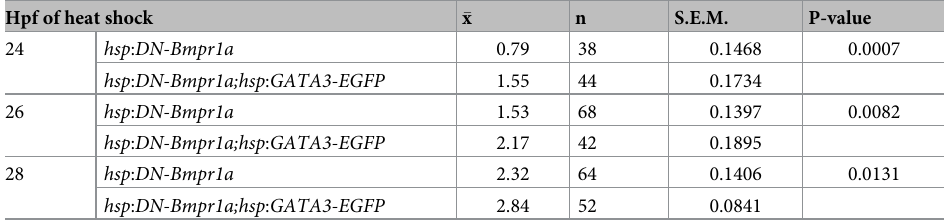
Table 3. Statistics for rescue of bmp